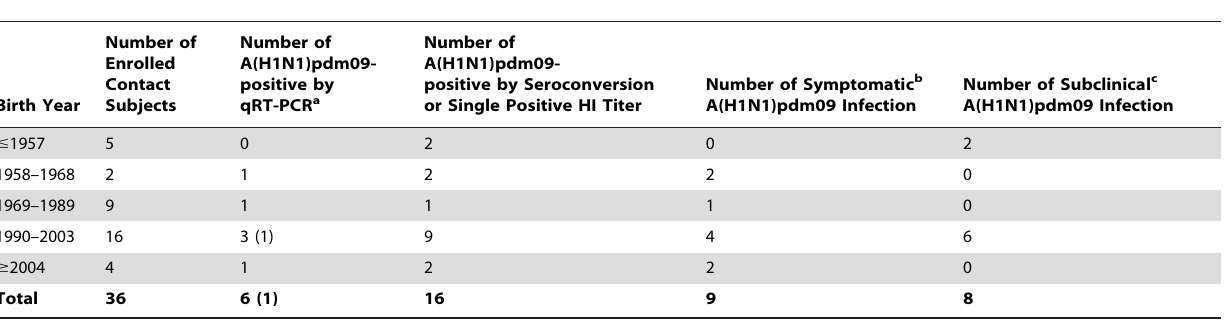
Table 4. Age distribution of contact subjects with laboratory-confirmed A(H1N1)pdm09 infection, Kamphaeng Phet, Thailand.